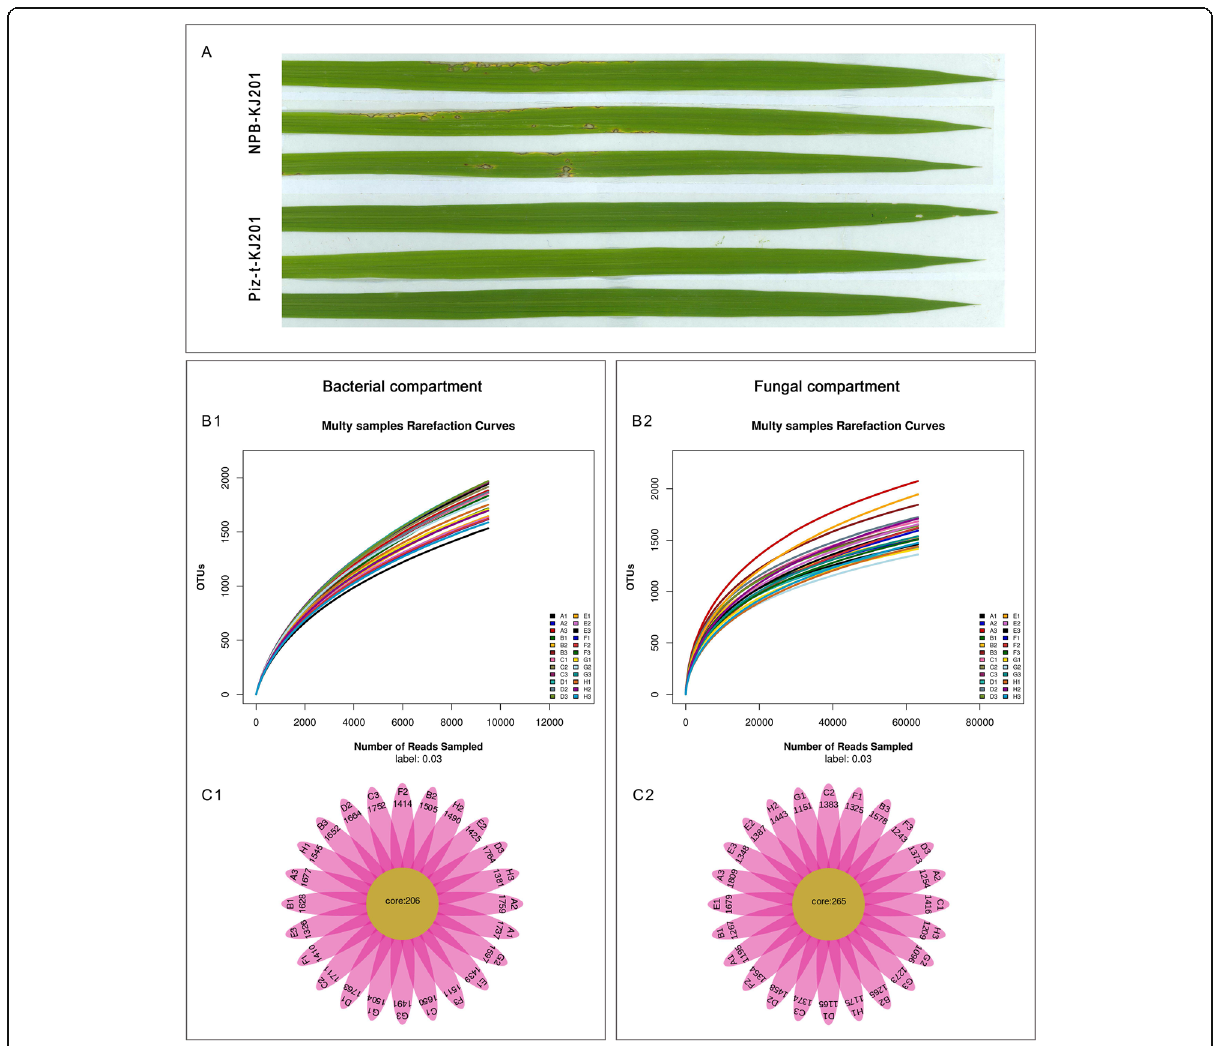
Fig. 1 Disease phenotype of NPB-KJ201 and Piz-t- KJ201 and the data analysis of each compartment. a Phenotype of NPB-KJ201 and Piz-t-KJ201 at 7 days post inoculation. b Rarefaction curves of each samples. The rarefaction curves were constructed based on read numbers for each OTU. c The QTU_flowers of fungal and bacterial compartments. Each petal represents a Sample, the core number in the middle represents the number of OTU common to all samples, and the number on the petal represents the number of OTU unique to the sample. Bacterial compartment, A:NPB-Mock-B.R, B: Pizt-Mock-B.R, C: NPB-KJ201-B.R, D: Piz-t-KJ201-B.R, E:NPB-Mock-B.E, F: Pizt-Mock-B.E, G: NPB-KJ201-B.E, H: Piz-t-KJ201-B.E; Fungal compartment, A:NPB-Mock-F.R, B: Pizt-Mock-F.R, C: NPB-KJ201-F.R, D: Piz-t-KJ201-F.R, E:NPB-Mock-F.E, F: Pizt-Mock-F.E, G: NPB-KJ201-F.E, H: